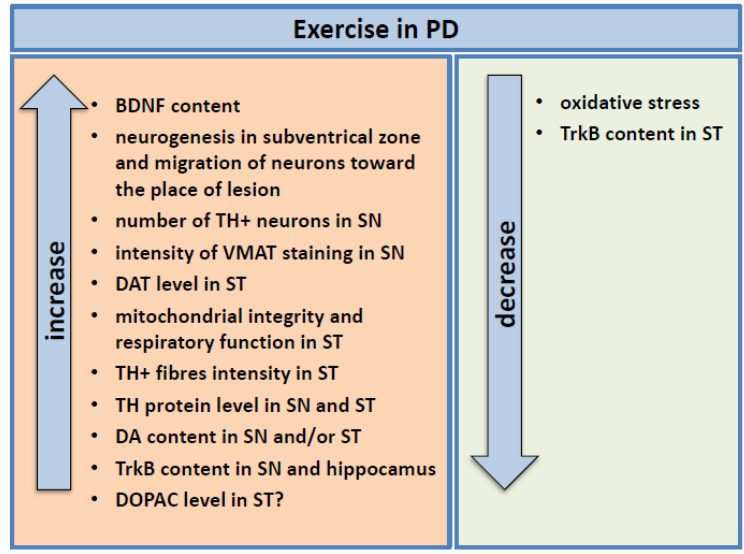
Figure 3. The molecular and physiological changes caused by exercise in animal models of Parkison’s disease. Physical effort led to an increase in BDNF level, TH-ir cell number and TH protein content in SN, TH-ir fibers intensity in ST, and DA content in SN and/or ST. The results from DOPAC content analysis in the brain were contradictory. Training also increased the level of TrkB